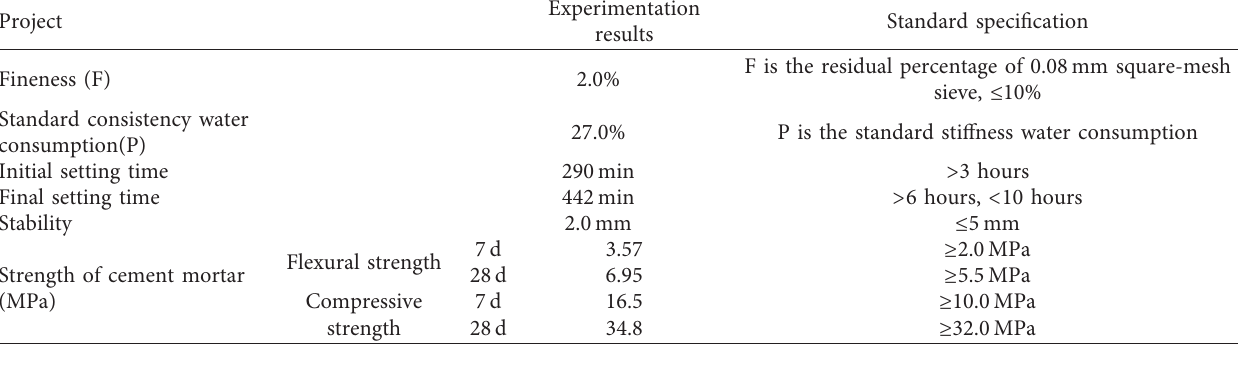
Table 3: The results of cement test performance.